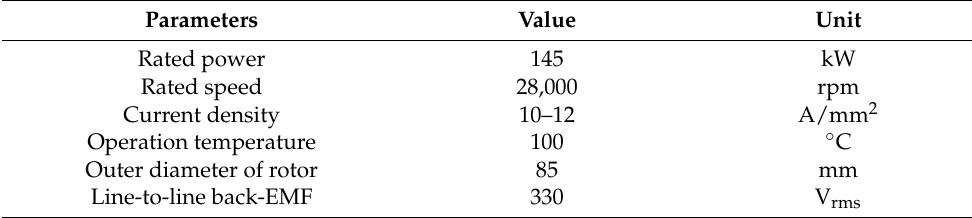
Table 1. Design Table 1. Design requirements.